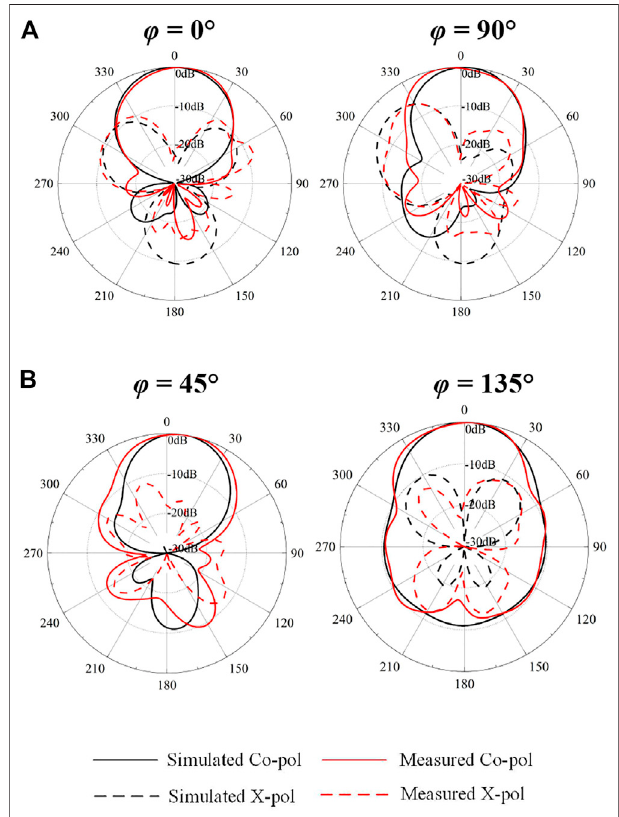
Figure 3 gives the simulated current distribution on the patches over a period when SW1 is ON and SW2 is OFF. At time t (cid:1) 0 and T/2 (T is a period of time), the current is along x -direction on Patch 1 and Patch 3 and current on the other two patches is minimized. At time t (cid:1) T/4 and 3T/4, the y -direction current is dominant on Patch 2 and Patch 4 and the current on Patch 1 and Patch 3 is weak. Therefore, CP radiation is realized when SW1 is ON and SW2 is OFF.